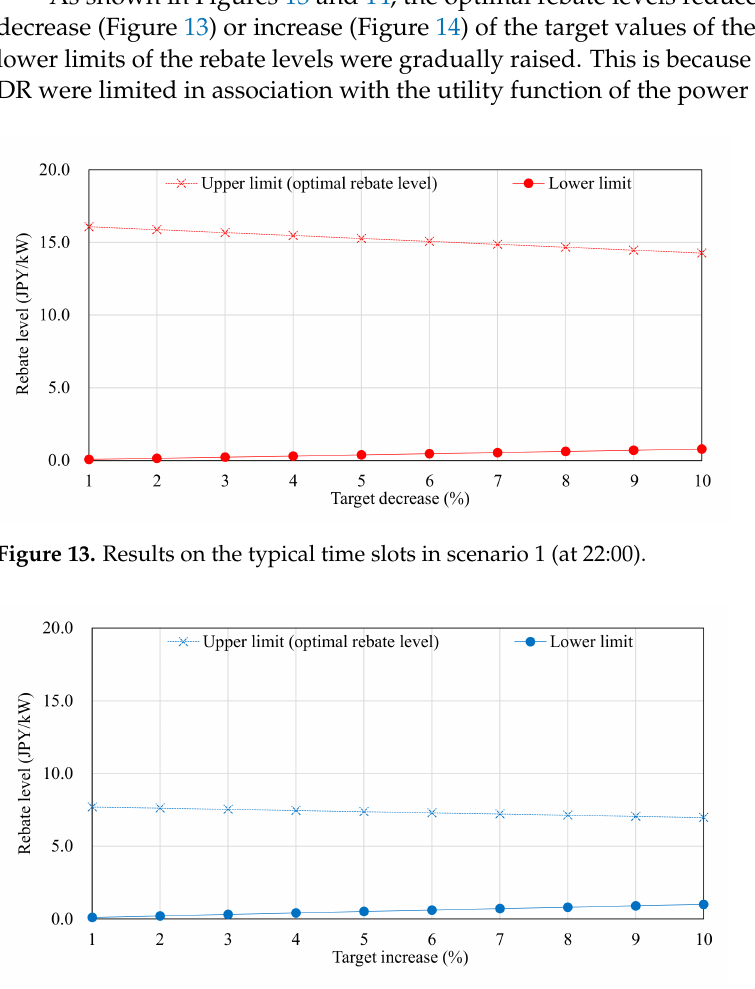
Figure 14. Results on the typical time slots in scenario 2 (at 4:00). In this scenario, the power suppliers could not request the DR cooperation from 18:00 to